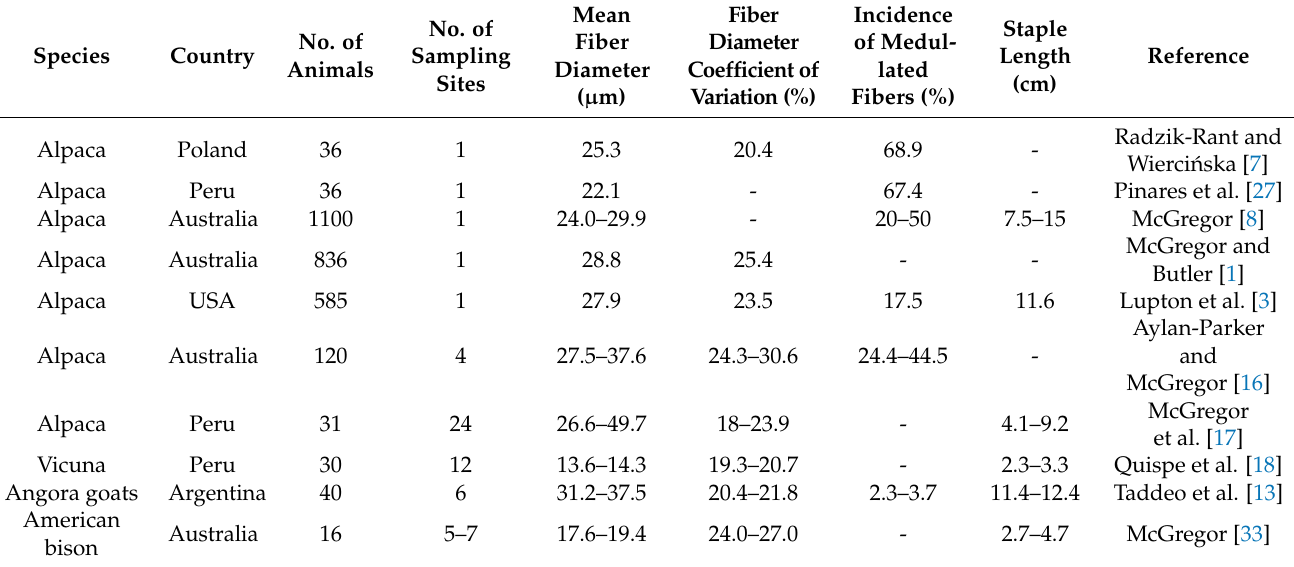
Table 6. The results of studies on wool quality carried out on various animal